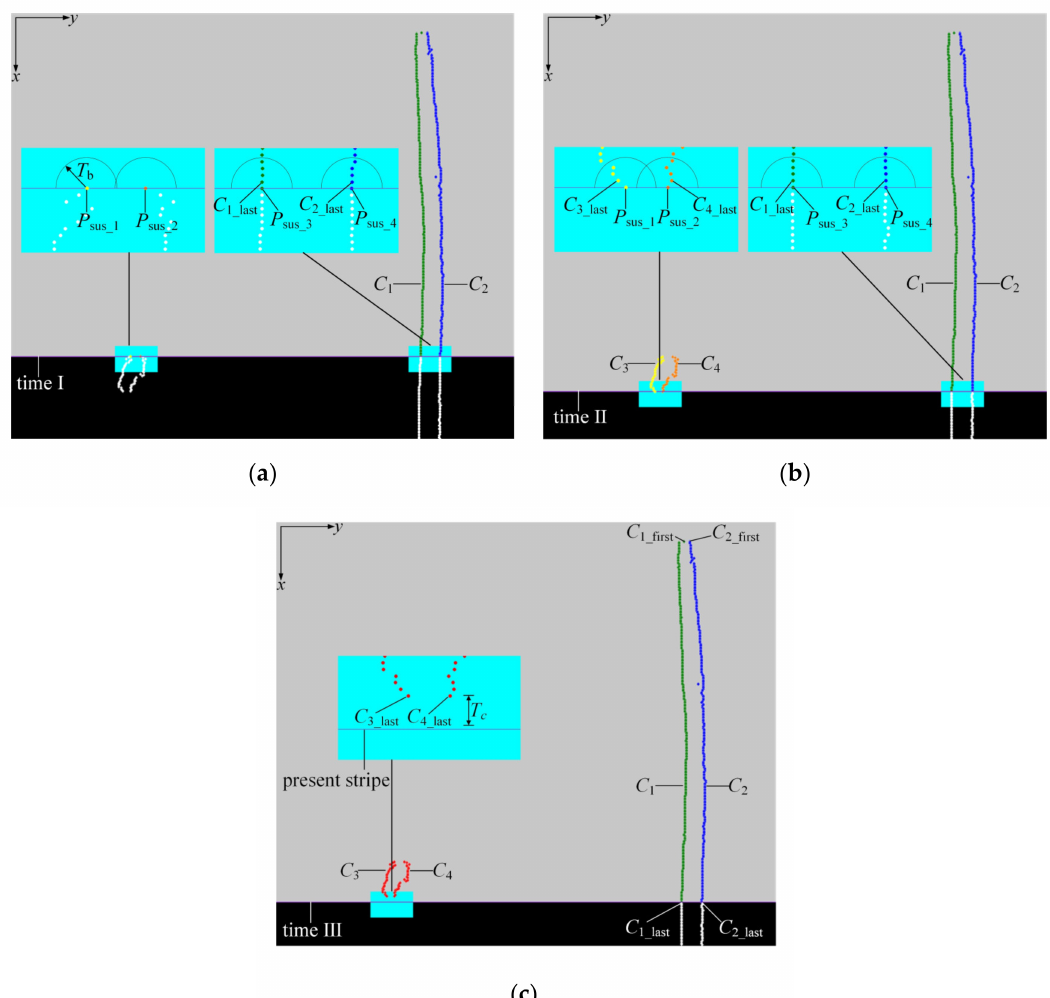
Figure 5. Clustering process and cluster elimination process: ( a ) the result of clustering process at time I. ( b ) The subsequent clustering result of ( a ) after several processing cycles at time II, coloring the points with different colors means the points are clustered in different clusters; ( c ) the result of cluster elimination process at time III, the red points are the invalid data that can be eliminated. In each subfigure, the middle illustrations are the zoom views of the lower little rectangle